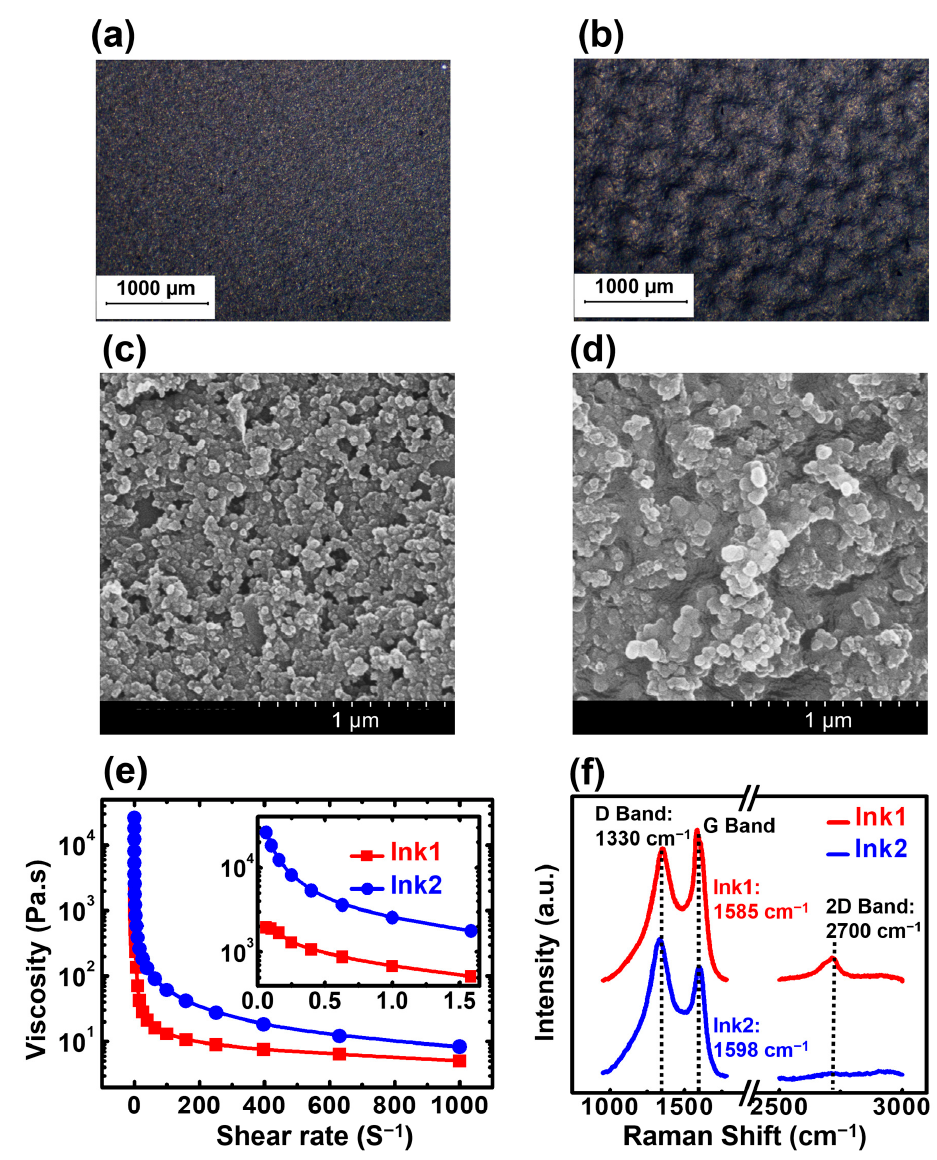
Figure 2. Optical microscope image of ( a ) Ink1 and ( b ) Ink2 over a glass substrate. SEM images of ( c ) Ink1 and ( d ) Ink2 over a glass substrate ( e ) viscosity data of Ink1 and Ink2 for the shear rate range of approx. 0–1000 S − 1 . The inset figure shows the viscosity data for the shear rate range of approx. 0–1.5 S − 1 ( f ) Raman spectra of Ink1 and Ink2 showing the material composition of both inks. The D, G and 2D bands were explored to understand the presence of graphene layers.